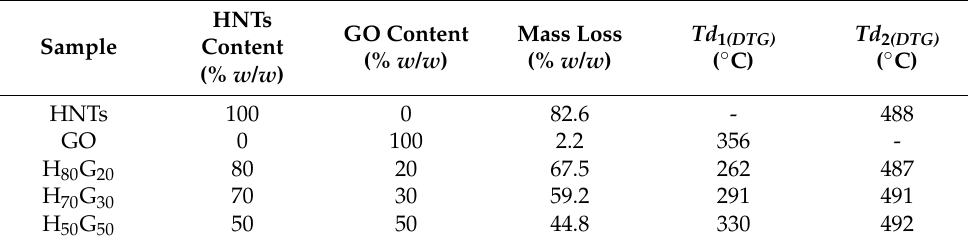
Table 3. TG-DTG analysis of tested materials: HNTs and GO content, mass loss, and decomposition temperature.